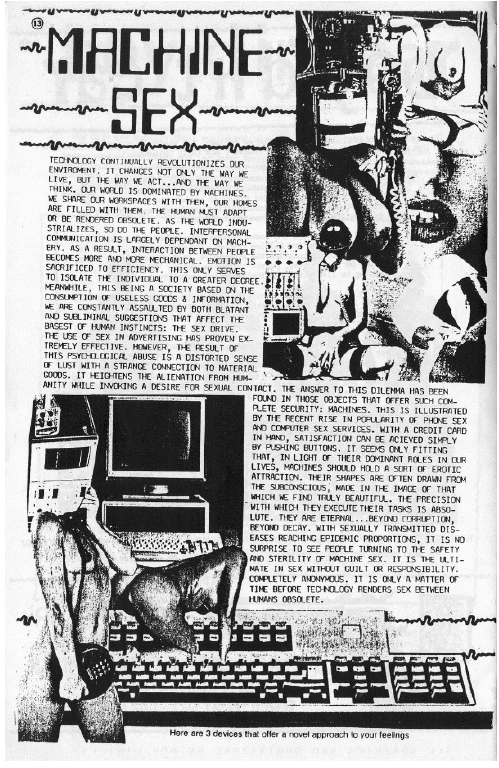
Figure 17. Intro page for “Machine Sex” by Thomas Thorn, U ‐ Bahn , No. 2, 1985. © U ‐ Bahn. Figure 14. “Machine Sex” by Thomas Thorn, U-Bahn, No. 2, 1985. © Magazine and collages by Thomas